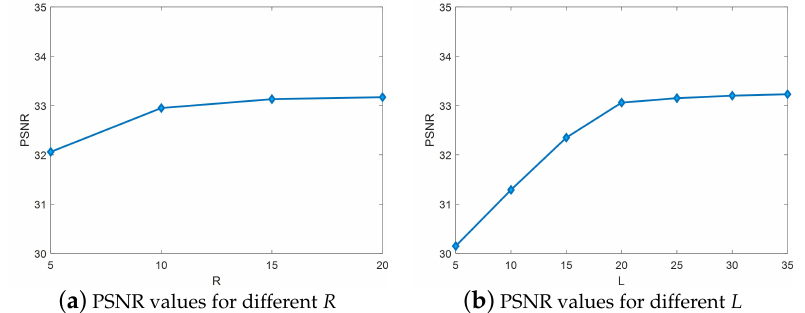
Figure 7. ( a , b ) PSNR values for different R and L in the Indian Pine